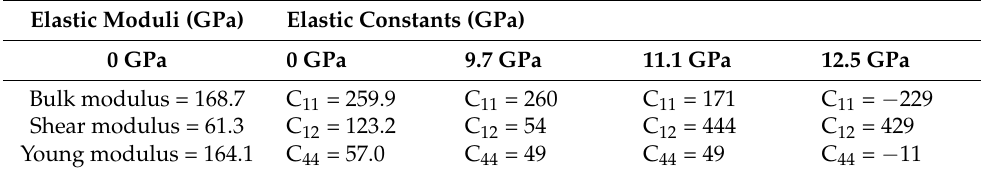
Table 2. DFT calculated elastic constants of S-FeVO. Elastic Moduli (GPa) Elastic Constants